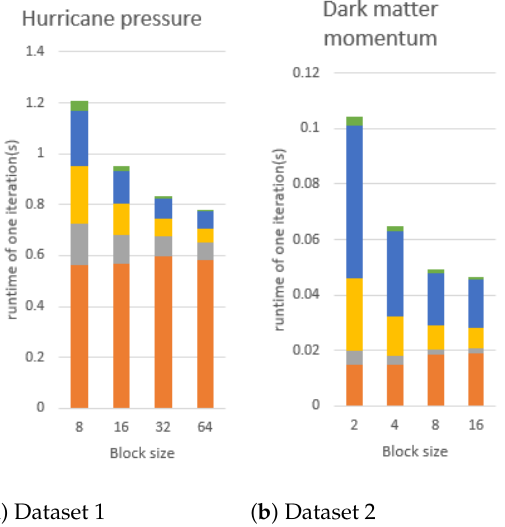
Figure 17. The execution time of GMM modeling if the number of Gaussian components is changed. The block size of ( a , b ) is fixed to 16. In the figures, orange, gray, yellow, blue, and green bars are the execution times of E-step , mean vector updating , covariance matrix flattening , and covariance matrix updating , respectively.